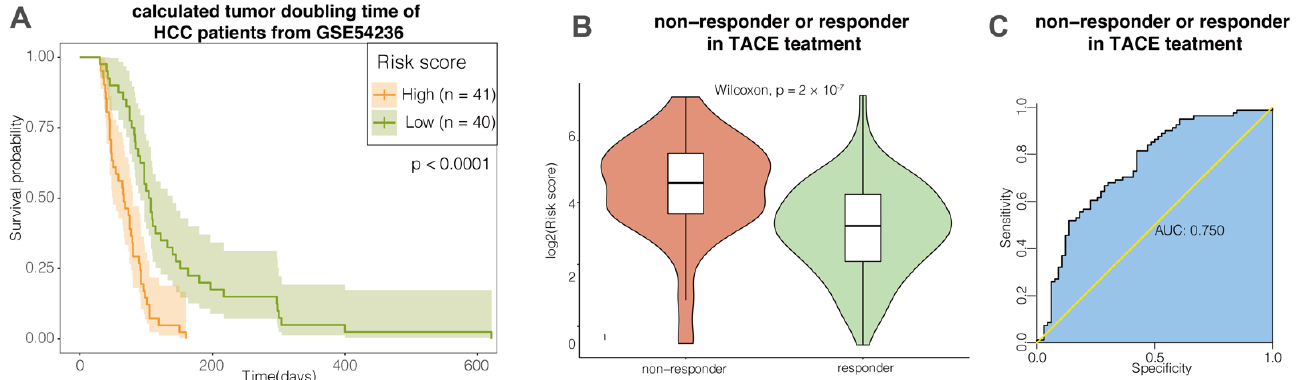
Figure 4. HCC stemness risk model (HSRM) was significantly associated with rapid tumor growth and TACE treatment response among HCC patients: ( A ) Kaplan–Meier analysis—HCC patients with higher HSRM scores had significantly shorter calculated tumor doubling time in the GSE54236 cohort; ( B ) violin plots of mRNAsi of HCC patients classified by response status to TACE treatment; ( C ) ROC curves demonstrate the clinical significance in predicting the response to TACE treatment in the GSE104580 cohort.